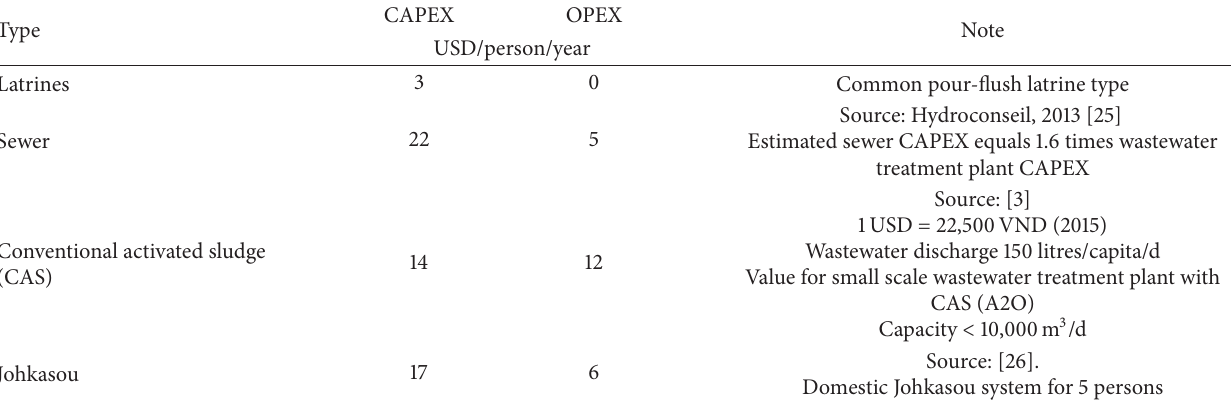
Table 6: Investment (capital expenditure, CAPEX, and O&M, OPEX) for the various wastewater treatment system.